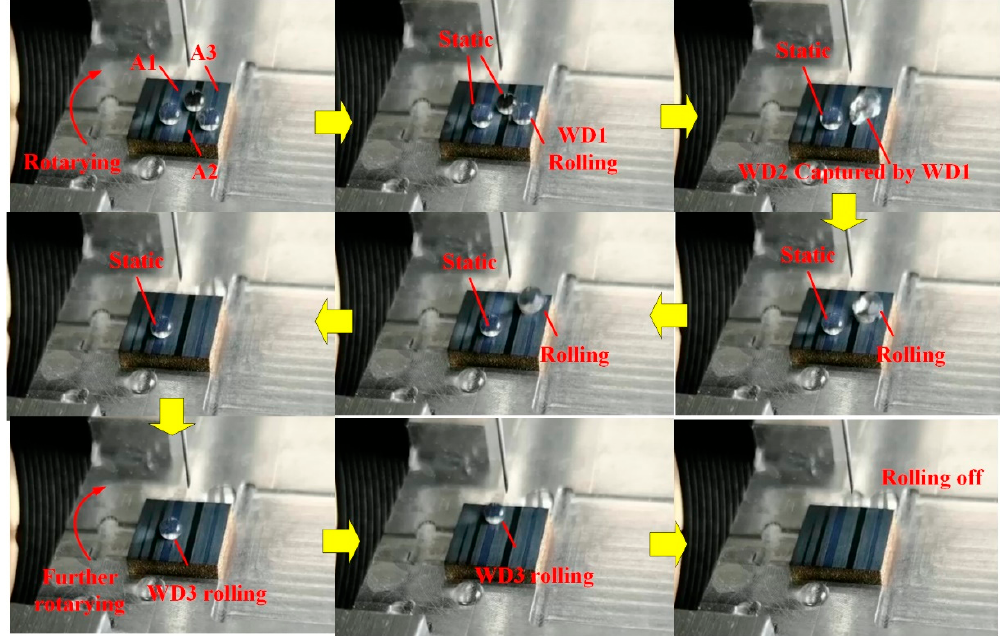
Figure 14. Functional surface with guiding property produced by using F p1 = 5.2 J / cm 2 and F p2 = 2.9 J / cm 2 .